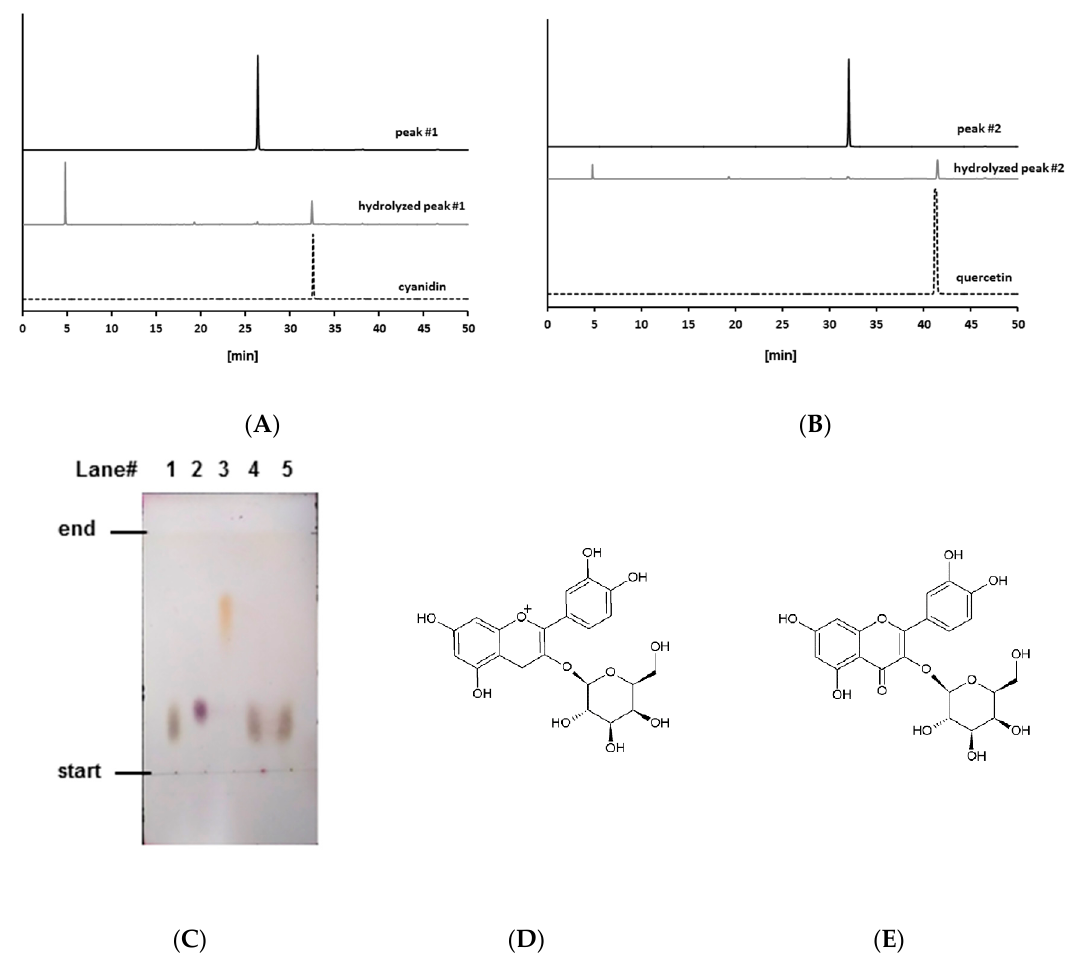
Figure 3. Identification of glycosides as antiglycative components of Persicaria hydropiper. ( A , B ) HPLC-UV chromatogram at 270 nm. ( A ) Isolated peak 1: before hydrolysis (black line), after hydrolysis (gray line), authentic standard of cyanidin (4 nmol, broken line). ( B ) Isolated peak 2: before hydrolysis (black line), after hydrolysis (gray line), authentic standard of quercetin (1 nmol, broken line). ( C ) Thin-layer chromatogram for saccharides. Lane 1, galactose (10 nmol); lane 2, glucose (10 nmol); lane 3, rhamnose (10 nmol); lane 4, hydrolyzed peak 1; lane 5, hydrolyzed peak 2. ( D , E ) Chemical structures of ( D ) cyanidin-3- O -galactoside (idaein) and ( E ) quercetin-3- O -galactoside (hyperin).